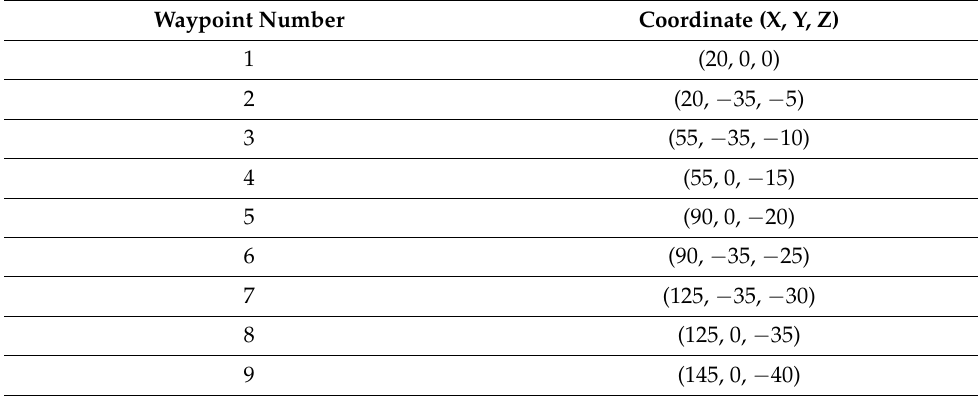
Table 7. The coordinates of waypoints in the 3D map. Unit: